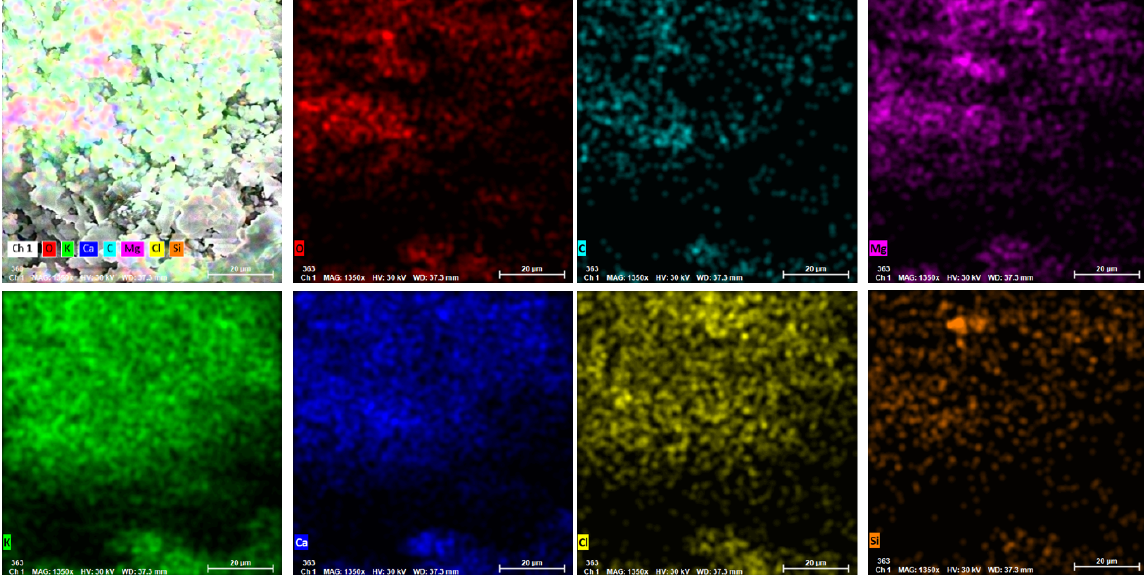
Figure 6. SEM images of the chemical elements of SA at a magnification rate of 20 µm.